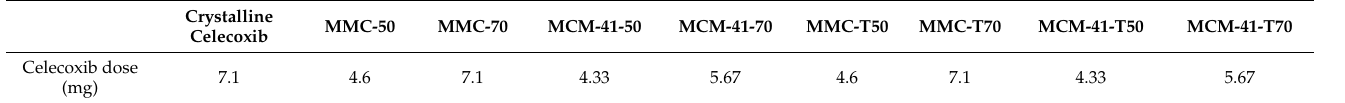
Table 1. Dosage of celecoxib within the formulations of MMC and MCM-41. Crystalline